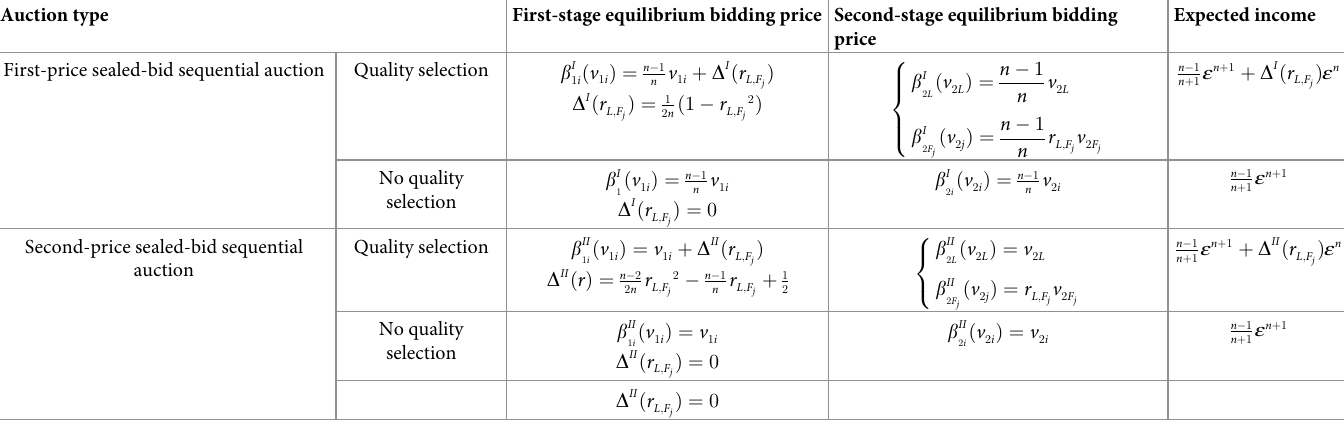
Table 4. Developers’ equilibrium bidding price and farmers’ expected income. Auction